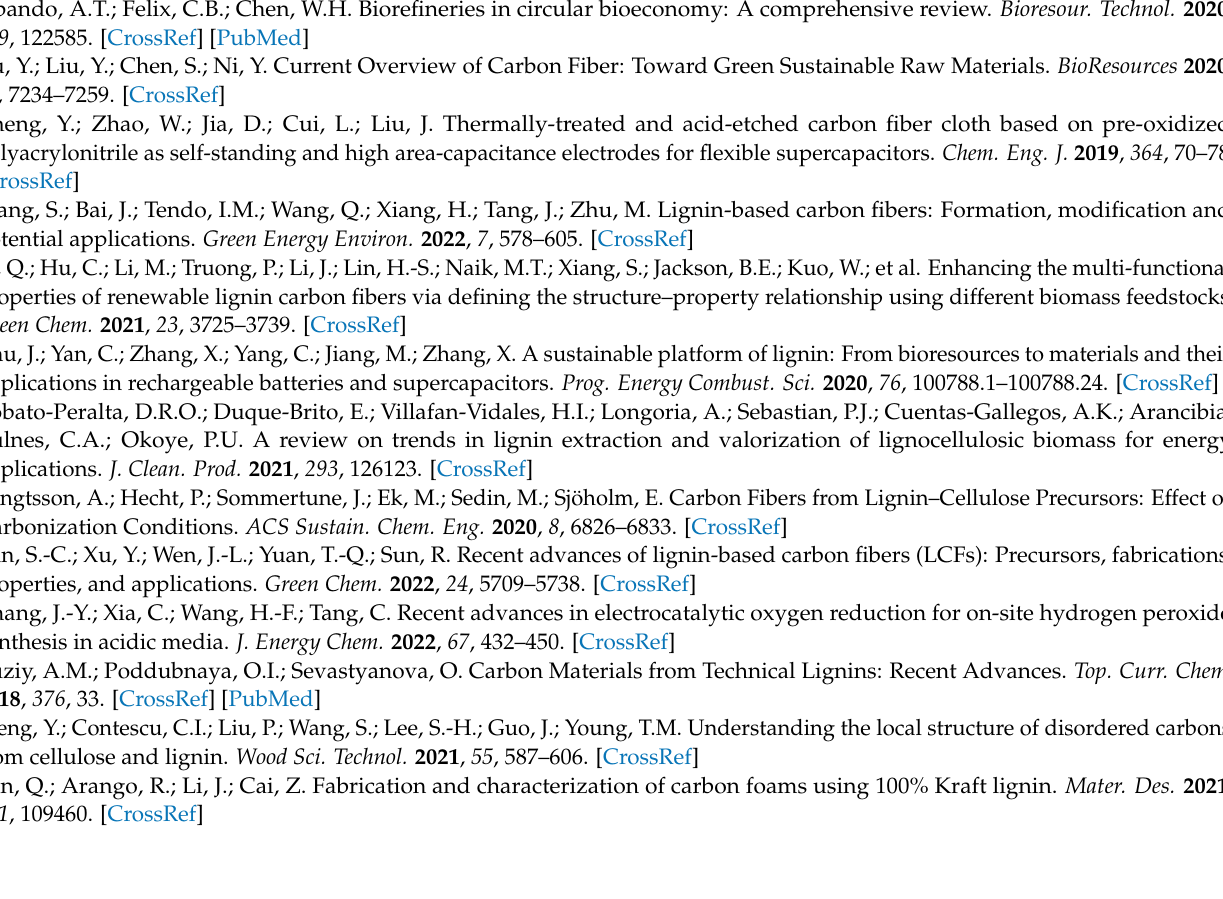
Figure S3. N2 adsorption/desorption isotherms; Figure S4. (a) CV for LCF-0.4 with different scan rate; (b) GCD curves for LCF-0.4 at different current